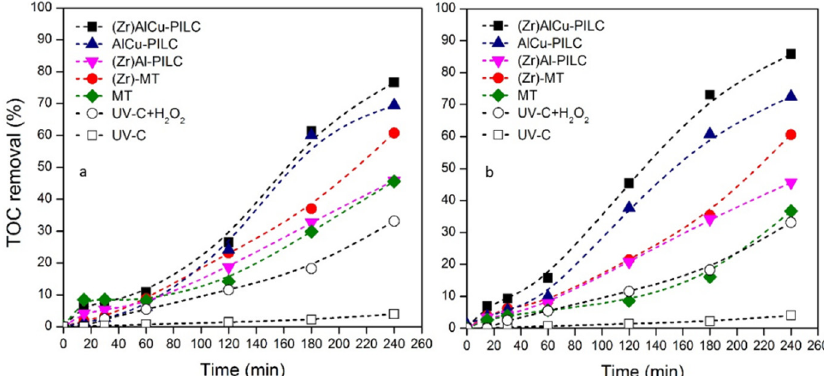
Figure 4. Evolution of TOC removal throughout H 2 O 2 -assisted photocatalytic process: ( a ) pH 4 and ( b ) pH 7 (catalyst dosage = 3.0 g / L, [H 2 O 2 ] 0 = 98 mM, [ TOC ] 0 = 500 mg C /